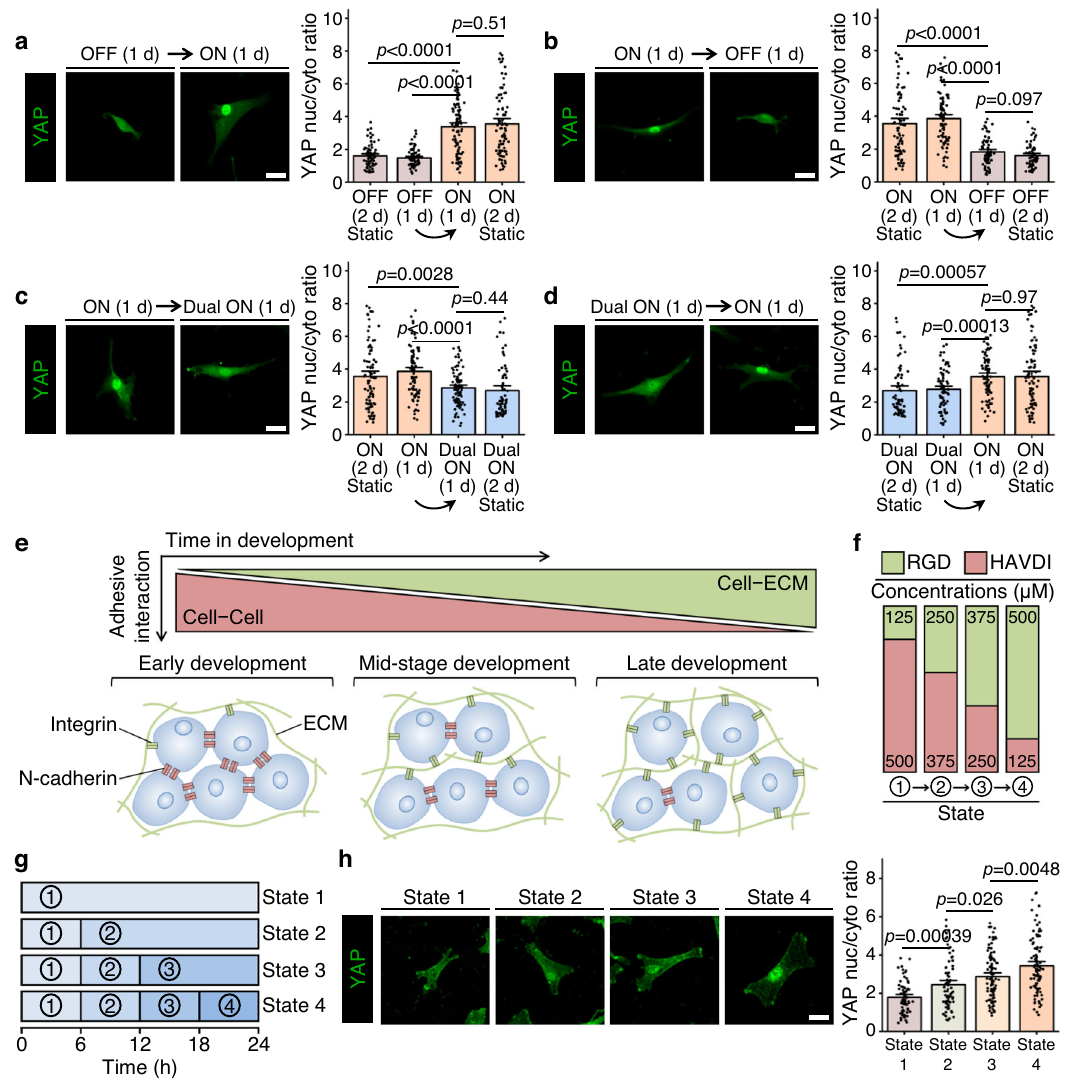
Fig. 3 | Programmable RGD/integrin and HAVDI/N-cadherin ligations regulate YAP signaling. a Left: Representative YAP images for state switching from “ OFF ” for initial 1 d to “ ON ” for subsequent 1 d. Right: Quanti fi cation of YAP nuc/cyto ratios(fromlefttoright n =67,74,93,82cells).Cellswereculturedoncontinuously “ OFF ” and “ ON ” substrates for 2 d as control groups. b Left: Representative YAP images for state switching from “ ON ” for initial 1 d to “ OFF ” for subsequent 1 d. Right: Quanti fi cation of YAP nuc/cyto ratios (from left to right n = 82, 85, 71, 67 cells). Cells were cultured on continuously “ ON ” and “ OFF ” substrates for 2 d as controlgroups. c Left:RepresentativeYAPimagesforstateswitchingfrom “ ON ” for initial 1 d to “ Dual ON ” for subsequent 1 d. Right: Quanti fi cation of YAP nuc/cyto ratios(fromlefttoright n =82,85,96,67cells).Cellswereculturedoncontinuously “ ON ” and “ DualON ” substratesfor2dascontrolgroups. d Left:RepresentativeYAP imagesforstateswitchingfrom “ DualON ” forinitial1dto “ ON ” forsubsequent1d.